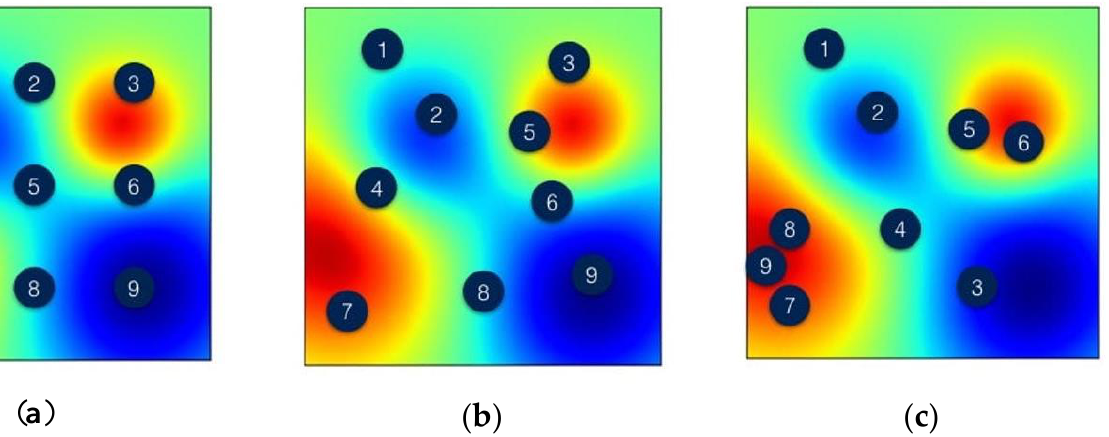
Figure 9. The comparison between ( a ) Grid Search vs. ( b ) Random Search vs. ( c ) BGA Optimization techniques for tuning the model’s hyperparameters.